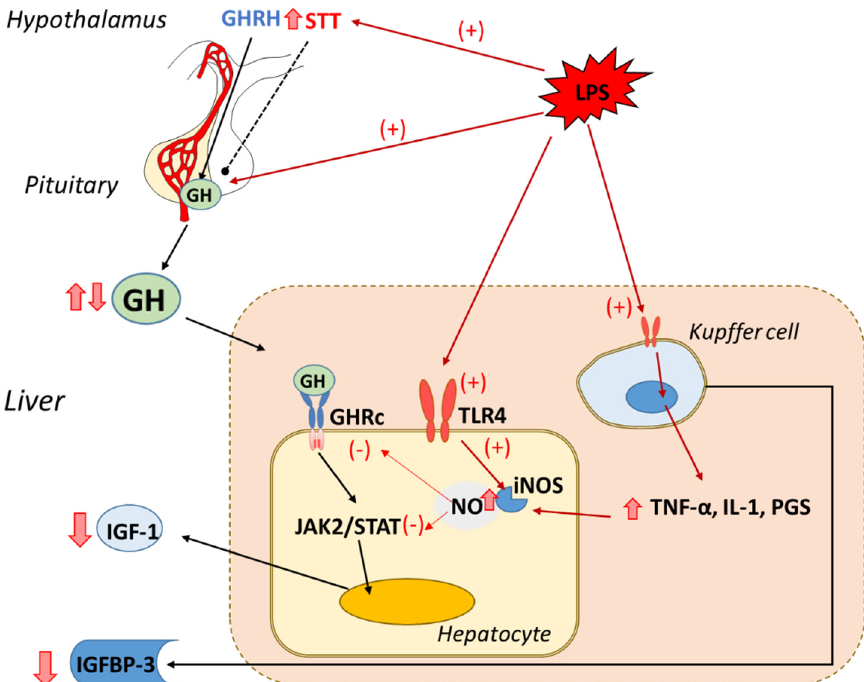
Figure 1. Effect of endotoxin or lipopolysaccharide (LPS) administration on the hypothalamic–GH– IGF-1 axis. At low dosage, LPS increased pituitary GH release, but with greater LPS dosages, an increase in hypothalamic somatostatin and a decrease in plasma GH is observed. Endotoxin directly decreased IGF-1 synthesis by hepatocytes through TLR4 activation, inducible nitric oxide synthase (iNOS) induction, and nitric oxide NO release. In addition, Kupffer cells, when stimulated by LPS, release inflammatory mediators (TNF- α , interleukins, and PGS), which further downregulate IGF-1 synthesis in hepatocytes. Whereas most IGF-1 is produced by hepatocytes, IGFBP-3 is mainly synthetized by Kupffer cells [49,50], and its synthesis is decreased by LPS. Red solid arrows indicate stimulatory (+) or inhibitory ( − ) effects of LPS. Black solid arrows indicate stimulatory and black dotted line indicates inhibitory effects of the hormones implicated in the GH-IGF-1 axis. Red border arrows indicate increased (upward) and decreased (downward) levels of the molecules/mediators in response to